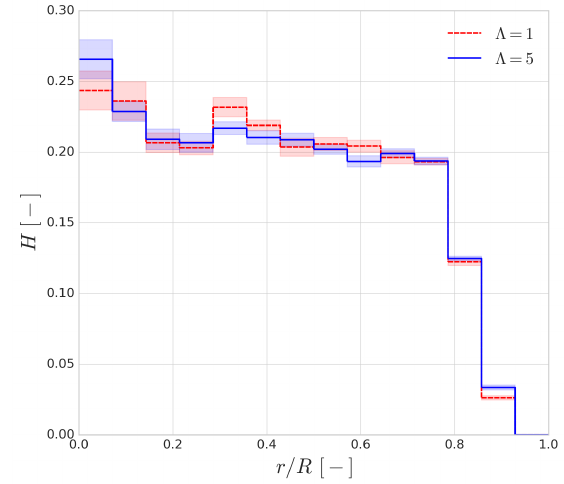
Figure 13. The haematocrit distribution in a straight circular channel flow simulation with a discharge haematocrit of 20%, 142 ms after the start of the simulation. r / R denotes the ratio of the distance to the centre of the channel with the radius of the channel. The shaded regions indicate the standard deviations of the haematocrit over the previous 30 ms.